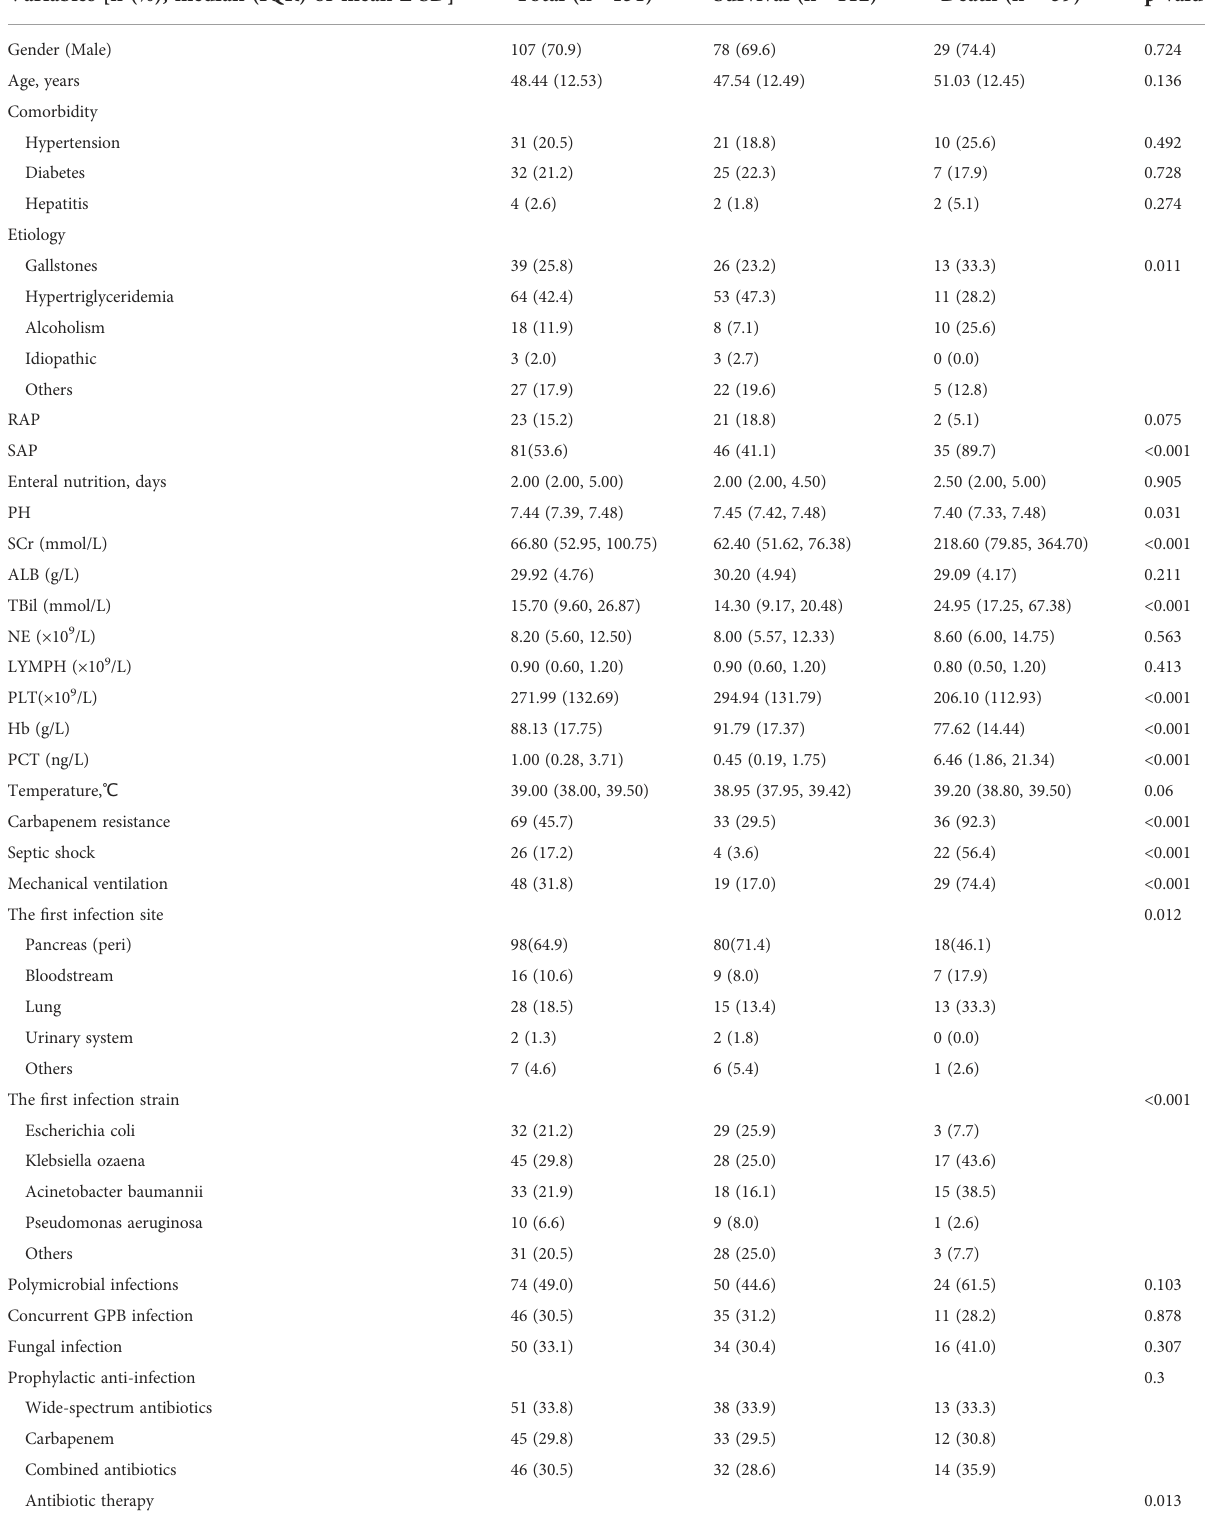
TABLE 1 Clinical characteristics and comparison between survival and mortality of 151 AP patients with GNB